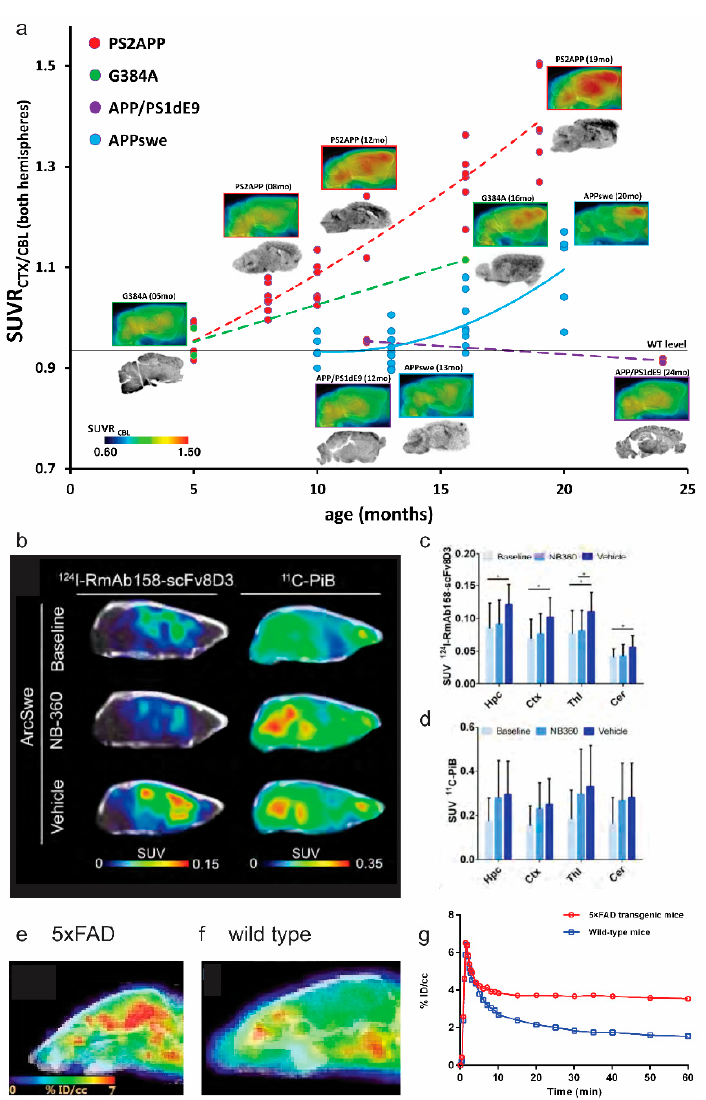
Figure 1. Imaging of amyloid-beta accumulation, and gamma-secretase in amyloidosis animal models of Alzheimer’s disease: ( a ) multi-modal analysis of the four AD mouse strains in cross- sectional [ 18 F]florbetaben PET study. Images indicate group averaged sagittal PET slices, normalized to the cerebellum as well as ex vivo autoradiography. Dots indicate PET SUVR cortex/cerebellum in individual mice. Dashed lines express the estimated time-dependent progression in PS2APP, APPswe/PS1G384A, and APP/PS1 mice, fitted with a polynomial function. Reproduced from [49] with permission from PLOS One; ( b – d ) PET images and quantification of [ 11 C]PiB (40–60 min after injection) and [ 124 I]RmAb158-scFv8D3 scans (72 h after injection) expressed as standardized uptake value (SUV): ( b ) comparison of representative [ 124 I]RmAb158-scFv8D3 and [ 11 C]PiB PET images in ArcSwe animals; ( c , d ) quantification of [ 124 I]RmAb158-scFv8D3 and [ 11 C]PiB in hippocampus (Hpc), cortex (Ctx), thalamus (Thl) and cerebellum (Cer). * p < 0.05. Reproduced from [55] with permission from the Society of Nuclear Medicine and Molecular Imaging; ( e – g ) PET–CT imaging of γ -secretase in 5 × FAD and wild-type mice; ( e ) PET–CT image of 5 × FAD mice ( n = 2) and ( f ) wild-type mice ( n = 2) after i.v. injection of [ 11 C]SGSM-15606; ( g ) time activity curve of whole- brain uptake of [ 11 C]SGSM-15606 in h and i. Data are expressed as the percentage of injected dose per cubic centimeter (% ID/cc). Reproduced from [59] with permission from Rockefeller University